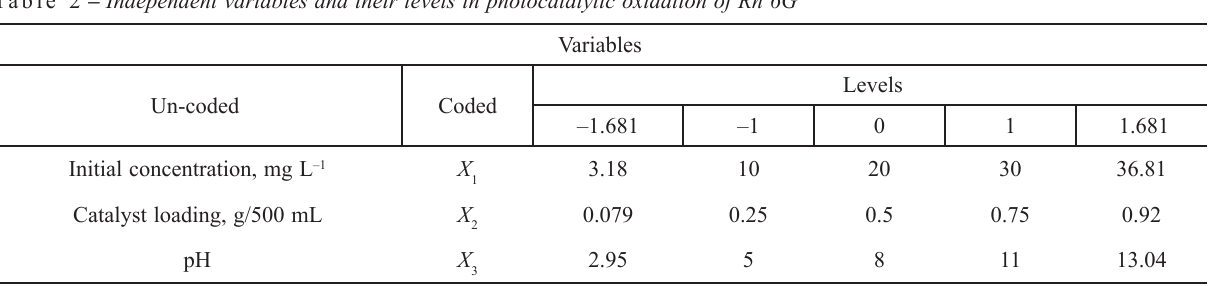
Table 2 – Independent variables and their levels in photocatalytic oxidation of Rh 6G